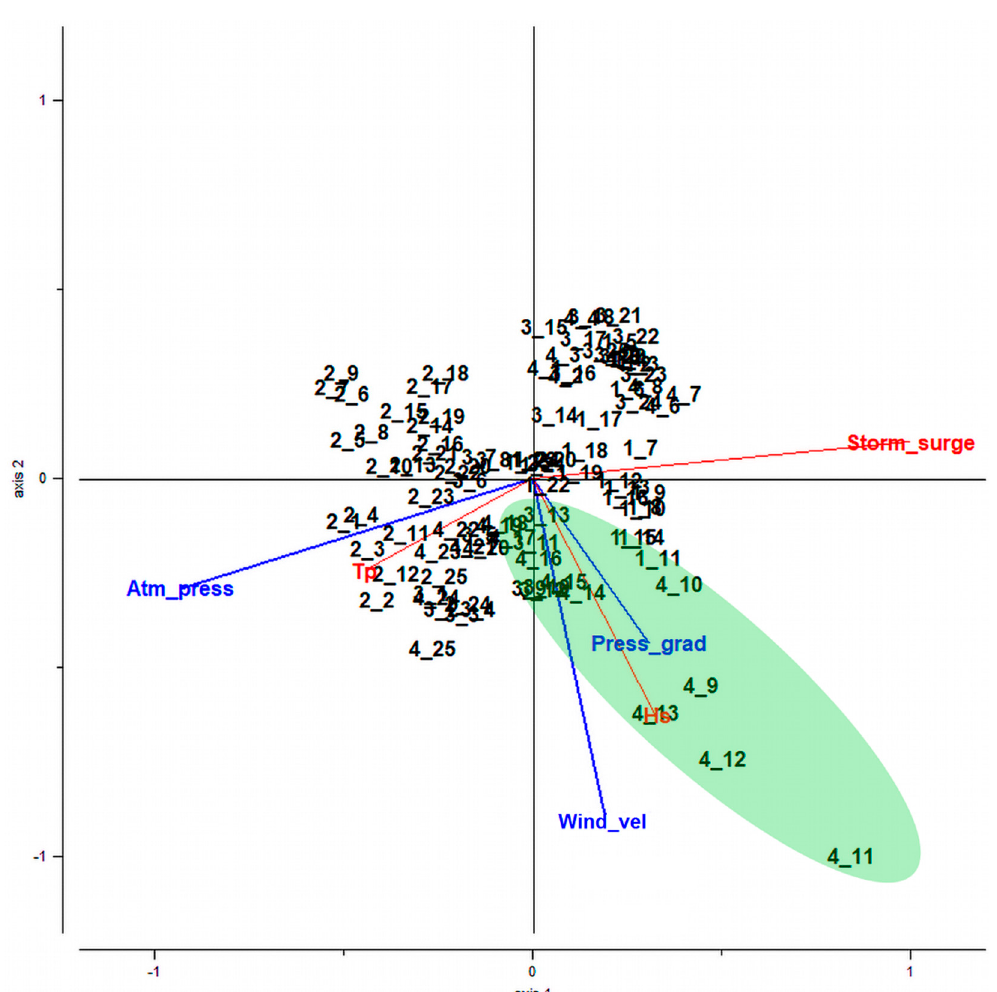
Figure 7. Redundancy Analysis (RDA) plot showing the relationship between the explanatory variables (Wind_vel: wind velocity; Atm_press: atmospheric pressure; Press_grad: gradient of atmospheric pressure) and response variables (Storm_surge: storm surge; Hs: significant sea wave height; Tp: peak period of sea wave). Each event is indicated using double numbering: the first number indicates the sea storm event (1: October 2012; 2: November 2013; 3: December 2013; 4: October 2018) while the second one indicates the sample number (from 1 to 25). The sum of all canonical eigenvalues is 0.34.